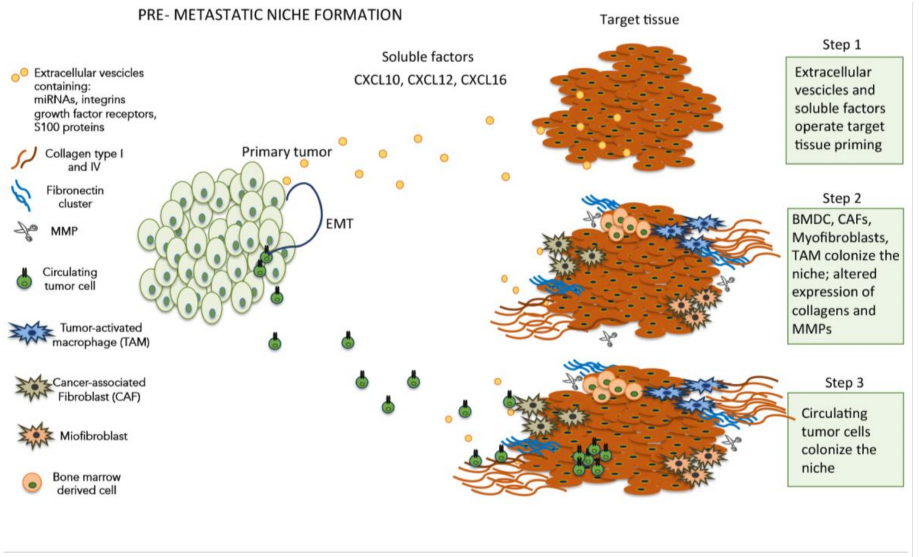
Figure 1. Cellular and soluble components involved in extracellular matrix (ECM) modifications during pre-metastatic niche